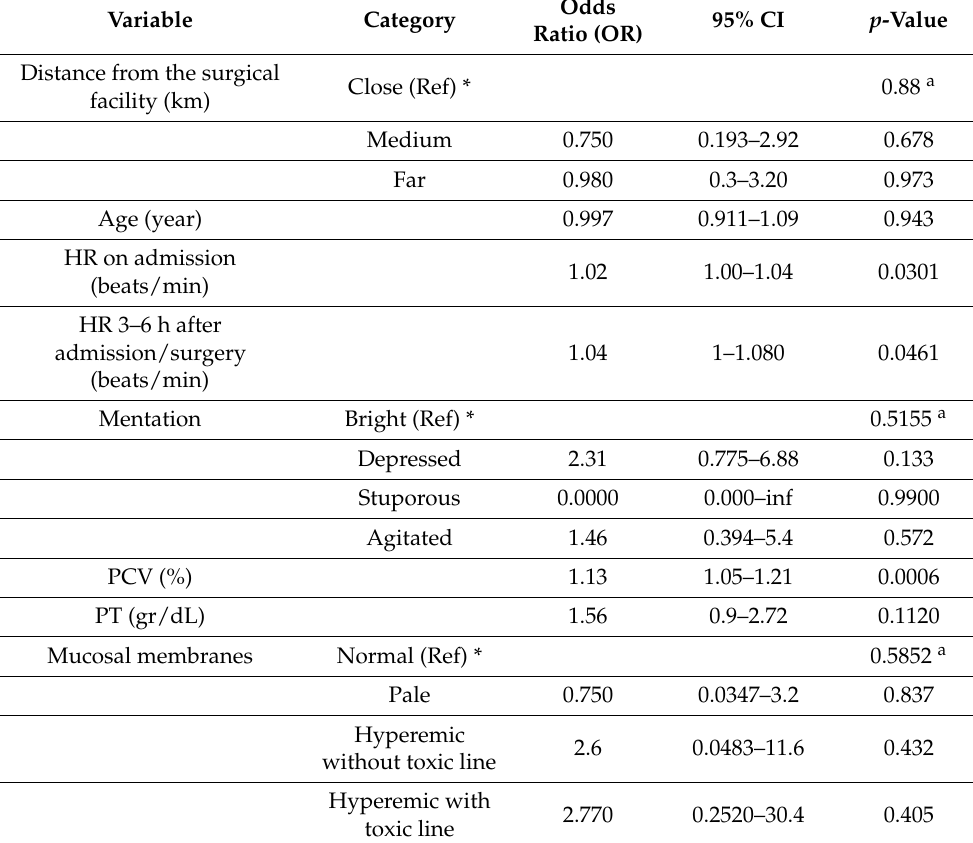
Table 10. Univariate logistic regression model showing the association between the explanatory variables and the outcome (=non-discharge) in 82 horses that received a surgical treatment for colic syndrome at the Veterinary Teaching Hospital of Teramo (OR: odds ratio; CI: confidence interval; CRT: capillary refill time; HR: heart rate; PCV: packed cell volume; TP: total protein; and BW: body